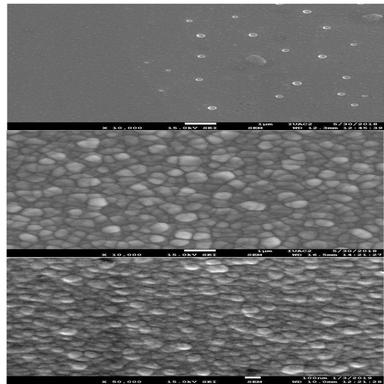
The surface morphology of 61Ni(top), 62Ni(middle) and carbon (bottom) films.